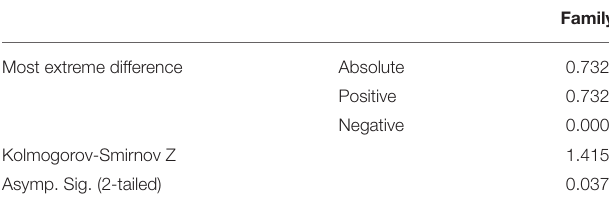
TABLE 12 | Test results of the index “family”.